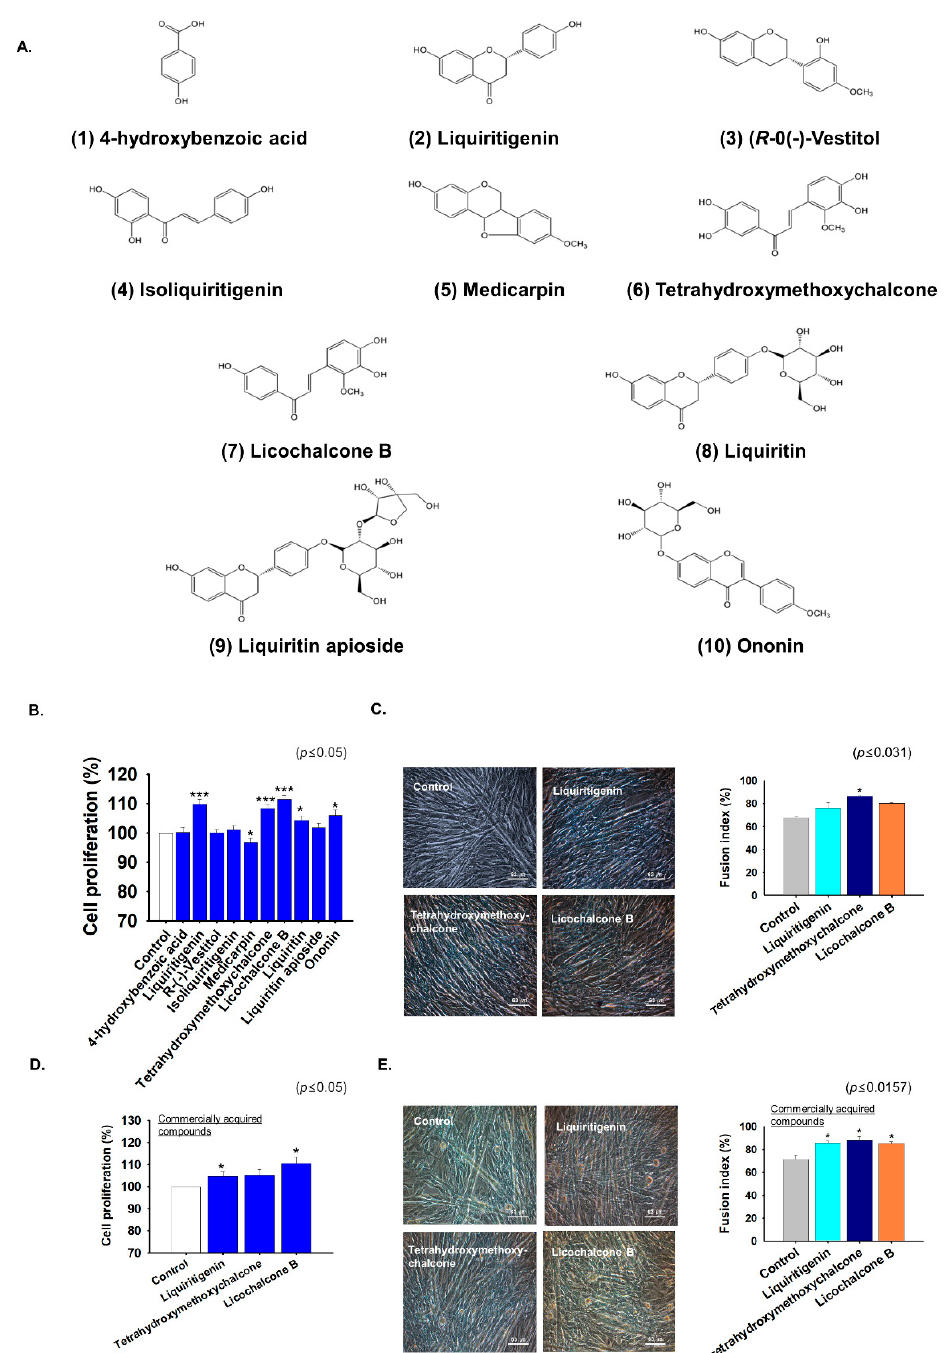
Figure 5. Cell proliferation and differentiation in the presence of single compounds present in the EtOAc fraction of the CWE of G. uralensis . ( A ) Structure of G. uralensis -EtOAc fraction derived single compounds. ( B ) C2C12 cells were incubated in growth media supplemented with either of the ten single compounds isolated from G. uralensis -EtOAc for 1 day. Cell proliferations in the presence of single compounds (0.25 ng/mL) determined by MTT assay. ( C ) When the cells have reached 100% confluency, cells were incubated in differentiation media supplemented with liquiritigenin, tetrahydroxymethoxychalcone, or licochalcone B (0.5 ng/mL) for four days. Myotube formation and fusion indices in the presence of the three compounds as determined by Giemsa staining. ( D ) Cell proliferation in growth media supplemented with liquiritigenin (0.25 ng/mL), tetrahydroxymethoxychalcone (0.25 ng/mL), or licochalcone B (1 ng/mL) as determined by MTT assay. ( E ) Cell differentiation in differentiation media supplemented with liquiritigenin, tetrahydroxymethoxychalcone, or licochalcone B at 0.25 ng/mL as determined by Giemsa staining. Non-treated cells were used as controls. Means ± SD ( n = 14). * p ≤ 0.05, *** p ≤